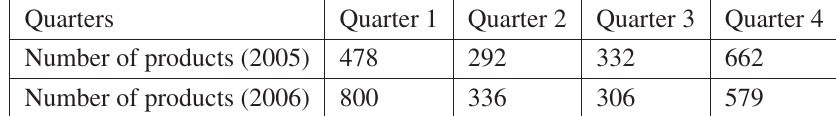
Table 5. The distribution of single quarter selling products.